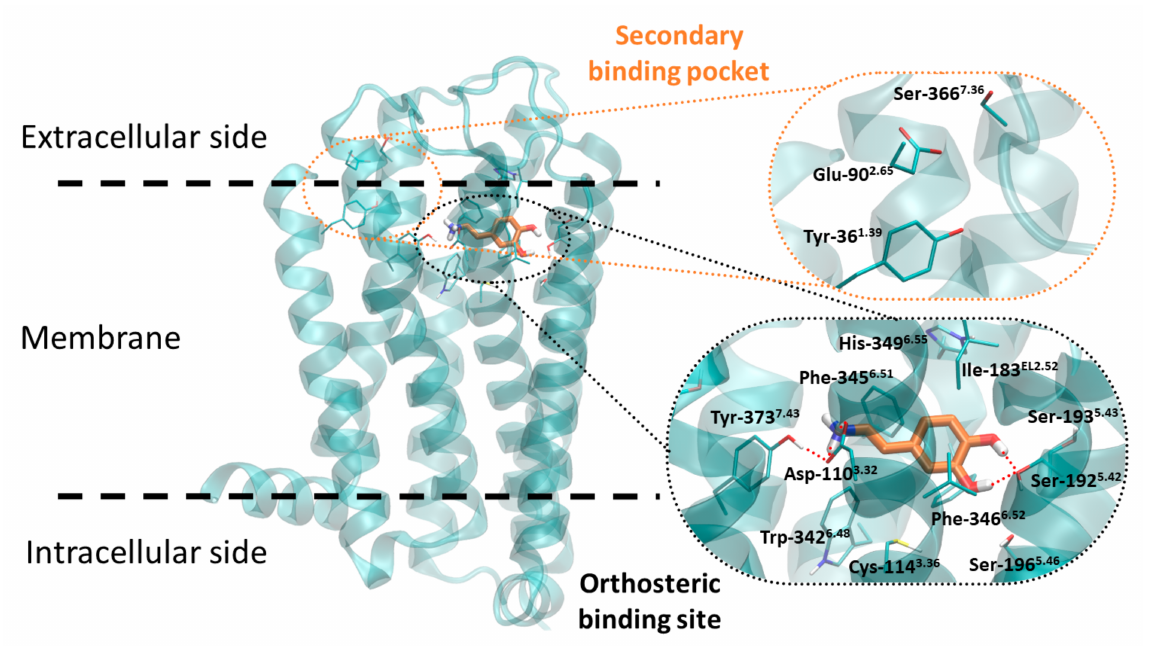
Figure 2. Structure of the hD3R, which contains the natural ligand (DA) docked into the crystal structure of D3R (ID is 3PBL in the Protein Data Bank;